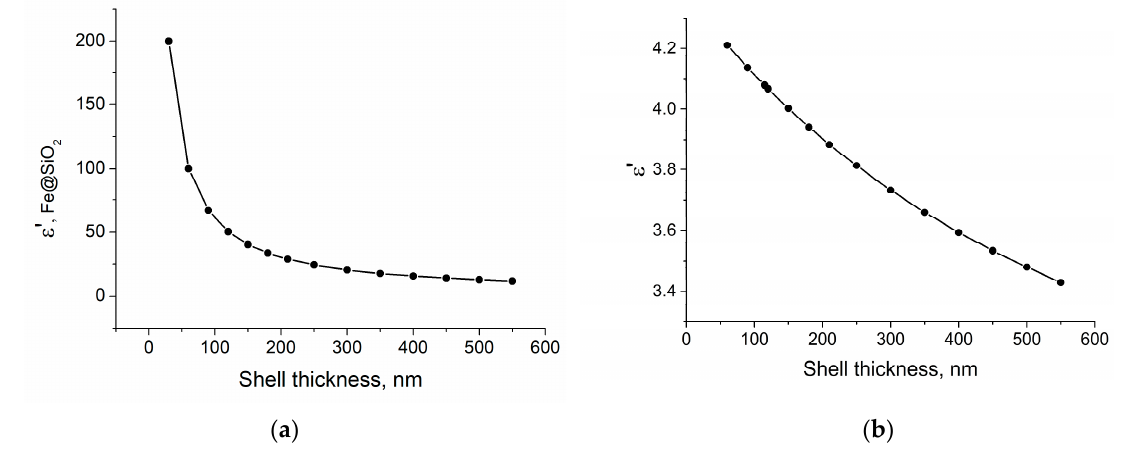
Figure 1. ( a ) Dependence of ε eff (Fe-SiO 2 ) on the SiO 2 shell thickness. ( b ). Dependence of ε eff (Fe-SiO 2 + wax) on the SiO 2 shell thickness.